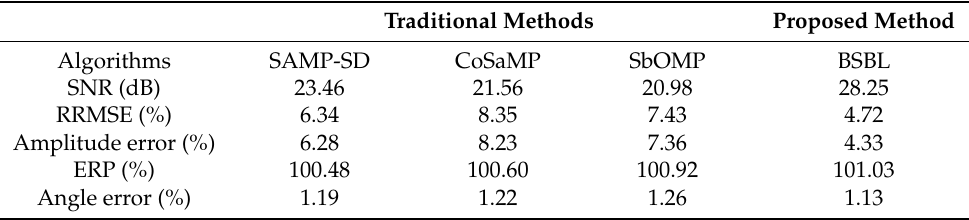
Table 9. Performance comparison of reconstruction algorithms (real-world harmonic signal).